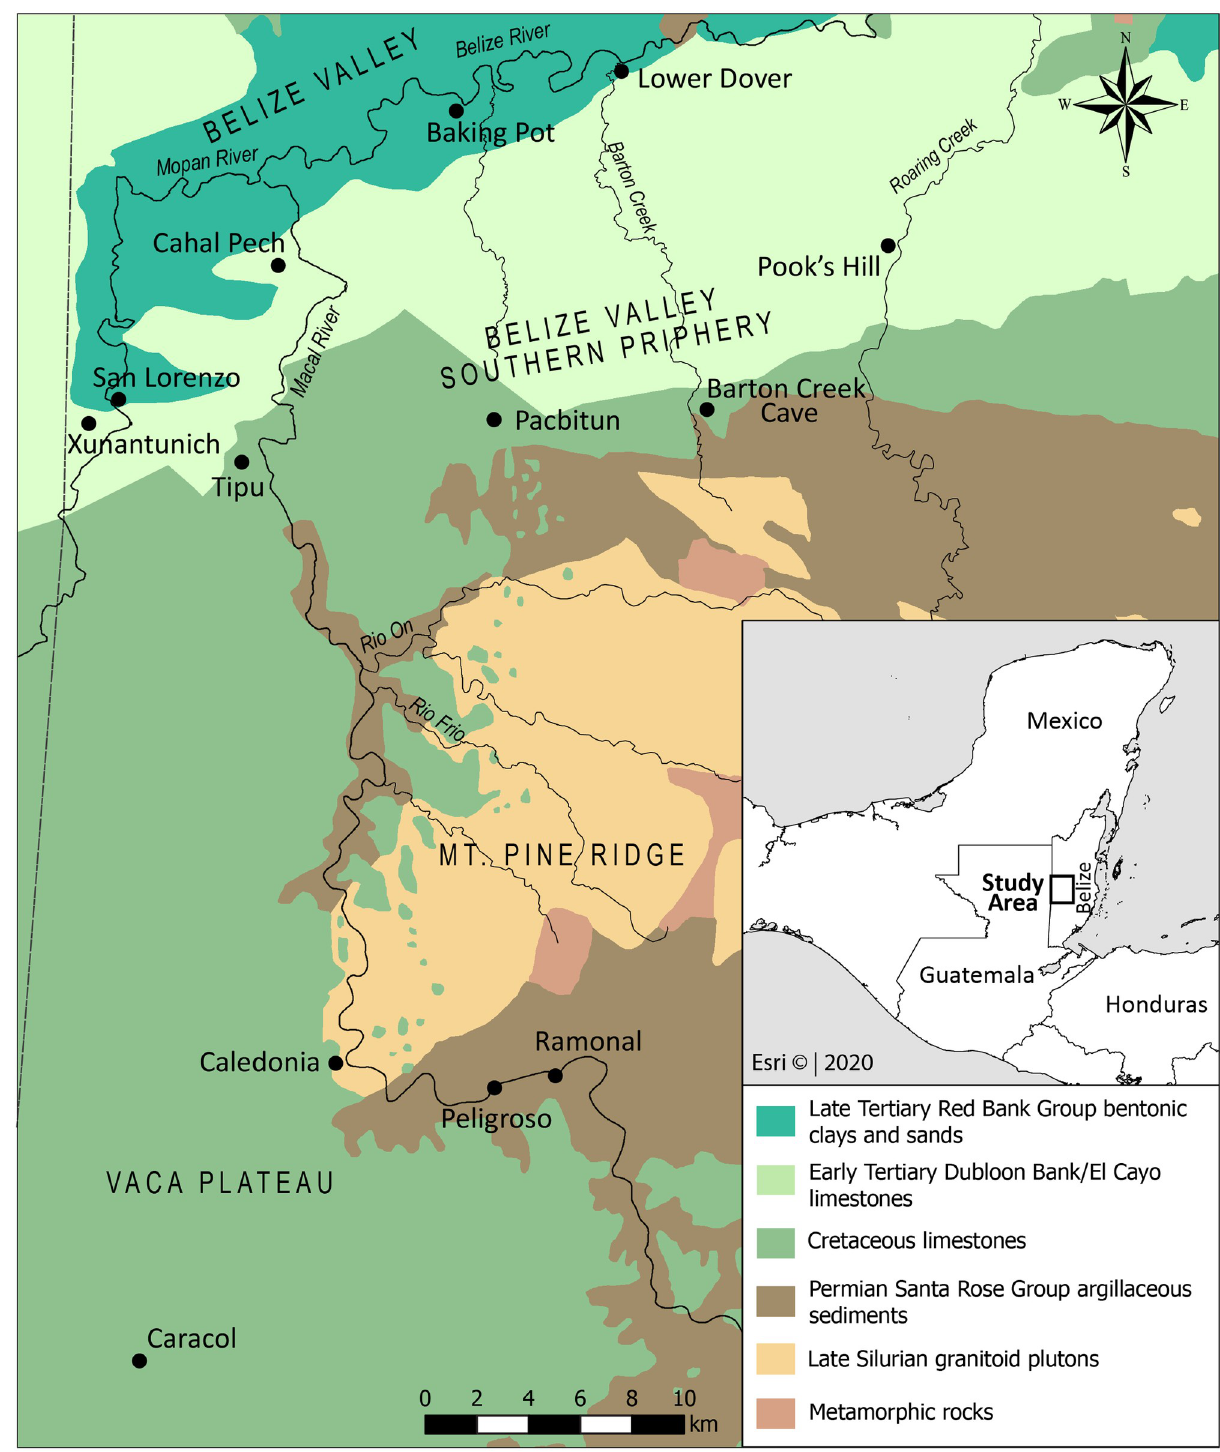
Fig 1. Location of sites in the Eastern Maya lowlands and corresponding bedrock geology (after [95]). Base map images are the intellectual property of Esri and are used herein under license. Copyright 2020 Esri and its licensors. All rights reserved.